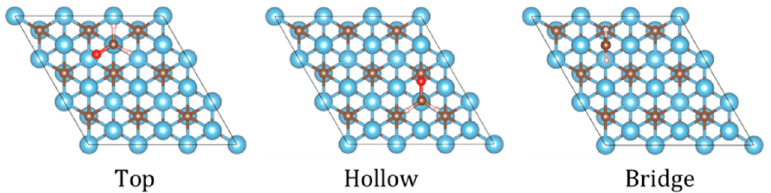
Figure 1. The adsorption configuration of HCHO at different sites on the surface of Ti 3 C 2 .